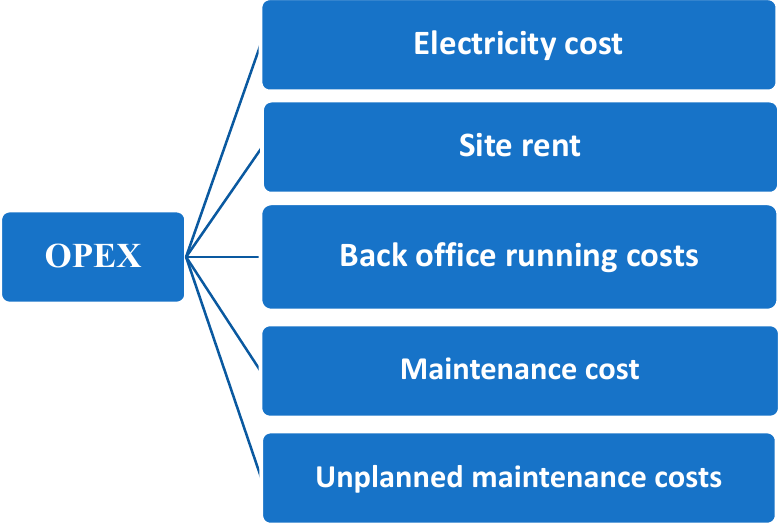
Figure 7. The models of OPEX [2].